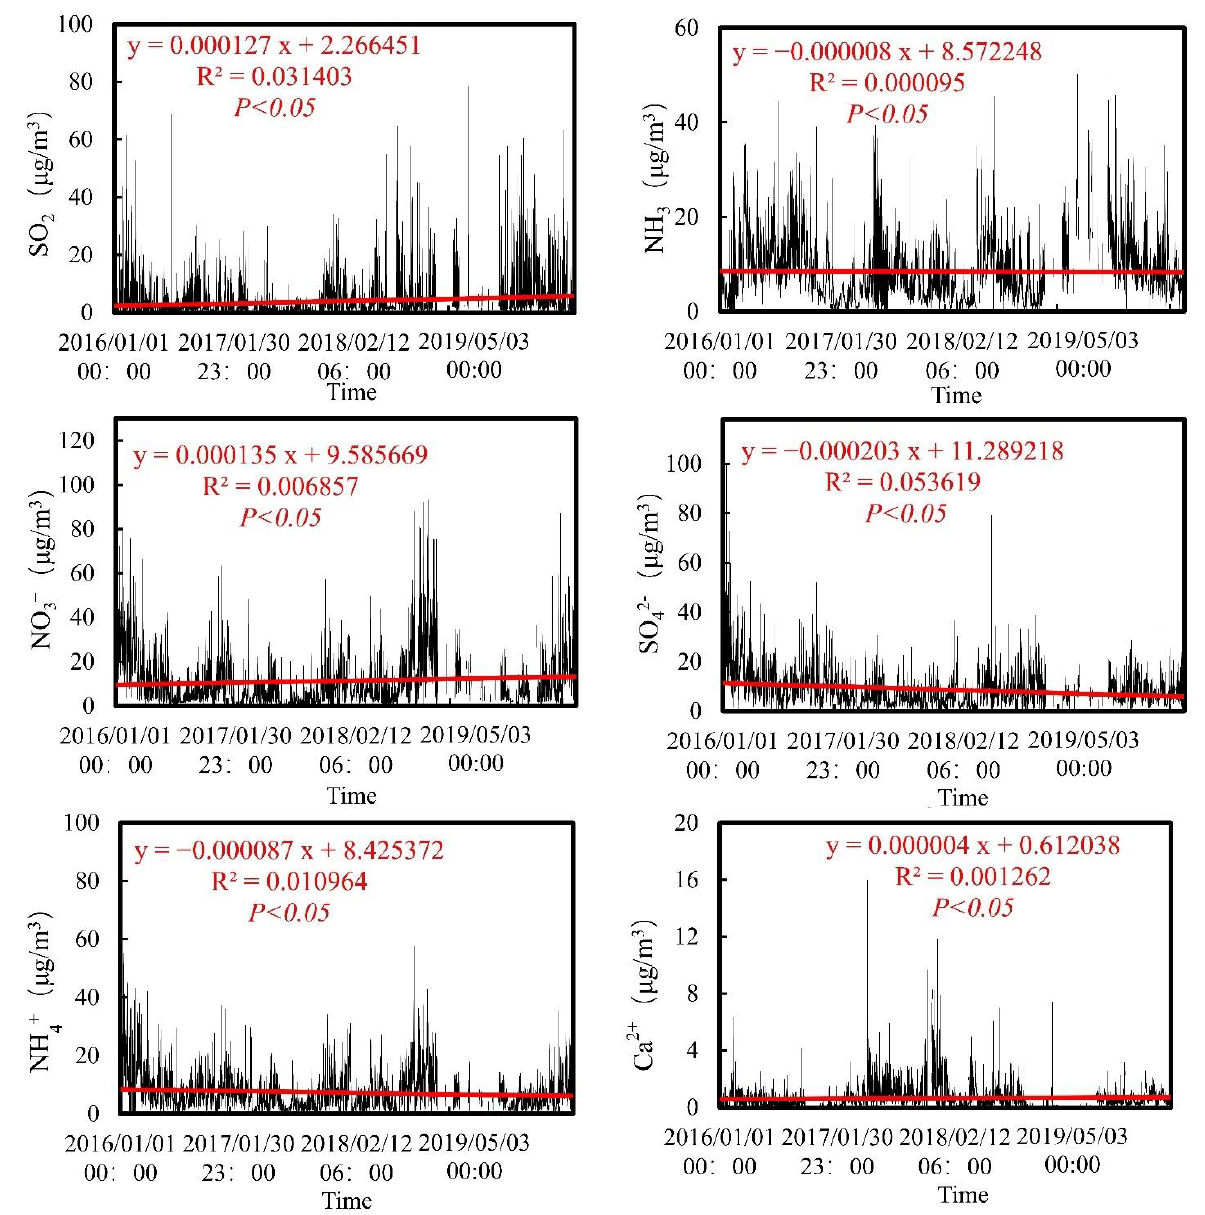
Figure 2. Concentrations of water-soluble ions in particulate matter in Wuhan, China during the period 2016 – 2019. The red dotted line represents the four-year trend line for each ion. R 2 represents the degree of fit of the trend line. P represents statistical significance .